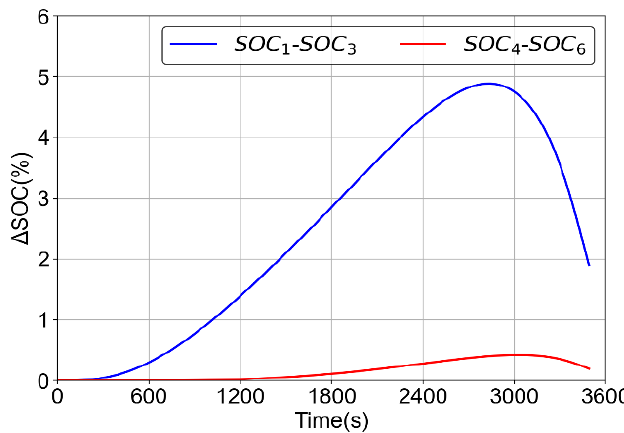
Figure 14. SOC difference of cells under the inhomogeneous cooling case